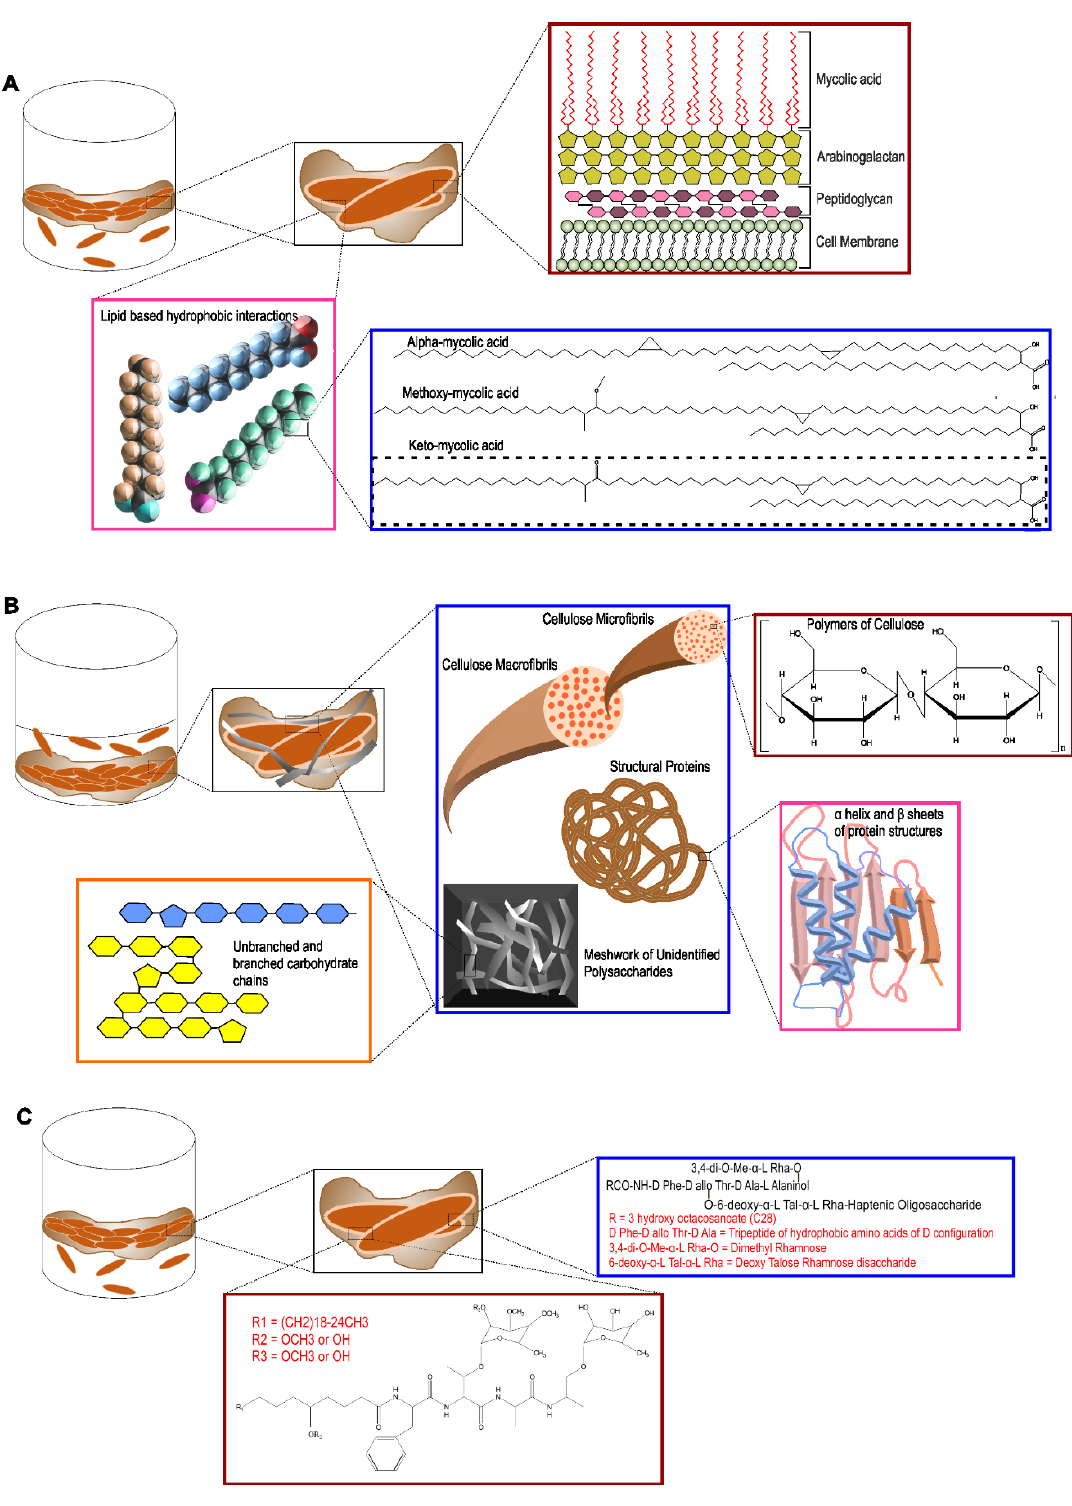
FIGURE 3: Different components of the extracellular polymeric substance of mycobacterial biofilms. (A) The pellicle biofilm model. The inset in maroon shows the different components of the mycobacterial cell wall. The inset in pink shows the lipid based hydrophobic interac- tions that hold the cells in the biofilm together. The inset in blue shows the different types of mycolic acids present in the extracellular bio- film matrix, the most abundant being keto-mycolic acid. (B) The thiol reductive stress induced submerged biofilm model of Mtb . The inset in blue shows the presence of polysaccharides, cellulose macro- and micro-fibrils, different structural proteins and meshwork of other uniden- tified branched and unbranched polysaccharides. (C) The pellicle biofilm model of M. smegmatis and M. avium . Apart from mycolic acids, glycopeptidolipids (GPLs) play a major role in pellicle biofilm formation in these bacteria. The inset in maroon depicts the GPL structure in M. smegmatis and the same in blue depicts the GPL structure in M. avium